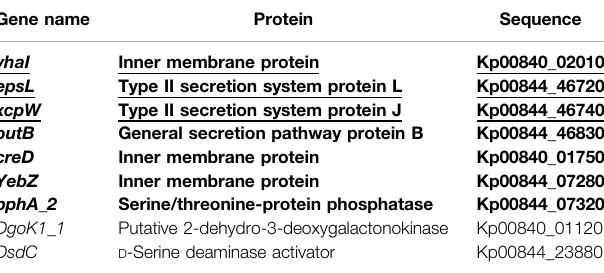
TABLE 3 | List of gene targets identi fi ed for the detection of K. pneumoniae